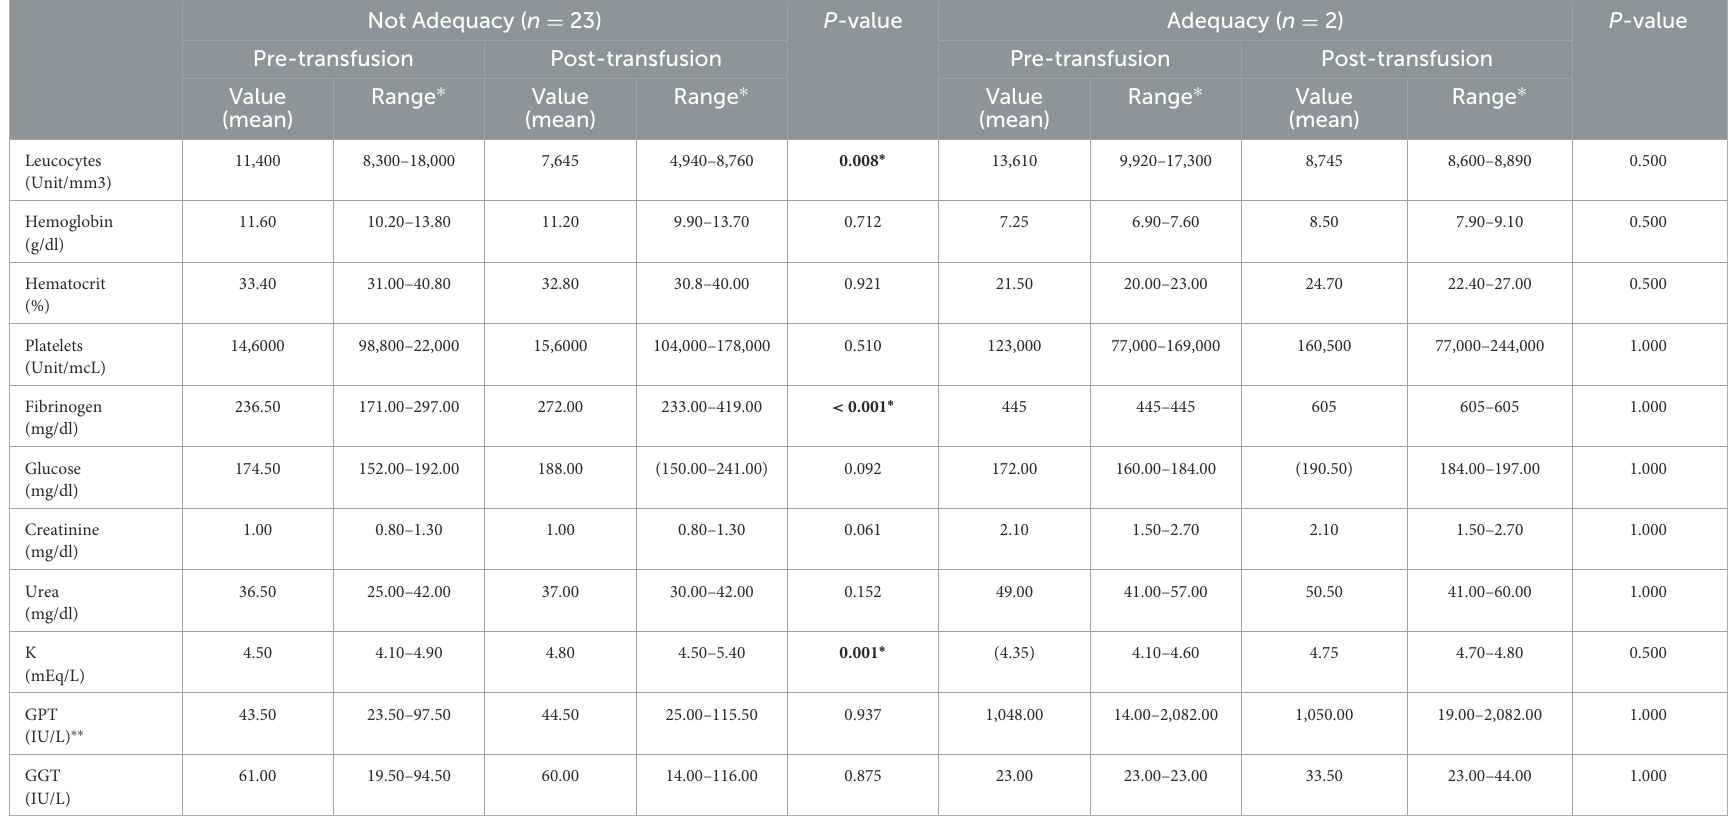
TABLE 5 Effect of the transfusion (adequate vs. inadequate) on the patient’s analytical